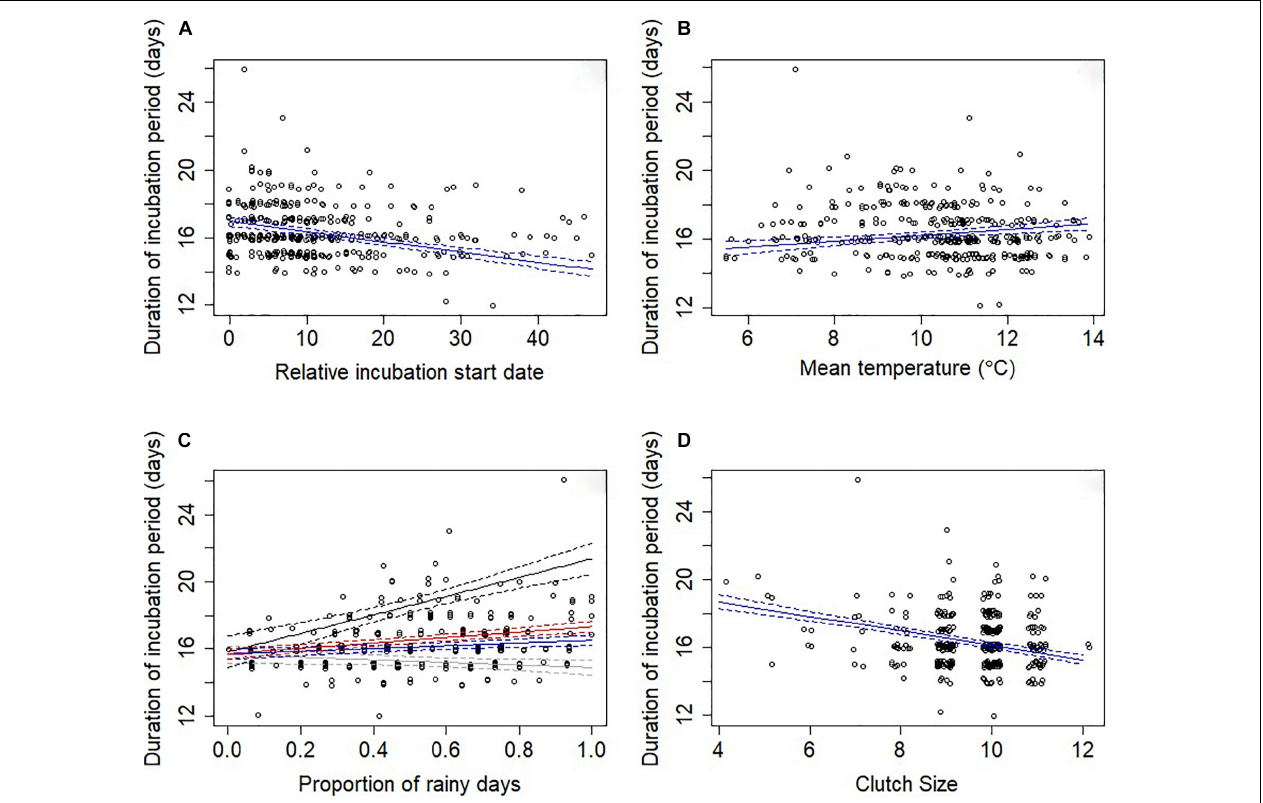
FIGURE 1 | Duration of the incubation period (days) in relation to (A) relative incubation start date, (B) mean temperature, (C) proportion of rainy days and (D) clutch size. Points have been offset so that overlapping points can be better seen. The solid lines indicate the predicted values from model-averaged parameters and dashed lines indicate the standard error. In (C) due to an interaction between proportion of rainy days and clutch size lines represent the model-averaged parameters when the clutch size was set to the lower quartile value (nine eggs; blue), to the upper quartile value (10 eggs; red), to the minimum value (four eggs; black) and to the maximum value (12 eggs; gray).